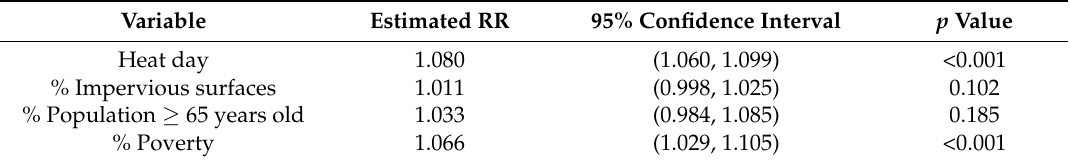
Table 2. Relative rate results: association between heat exposure (heat day versus non-heat day) and daily BLS call volume, adjusting for community-level factors 1 .